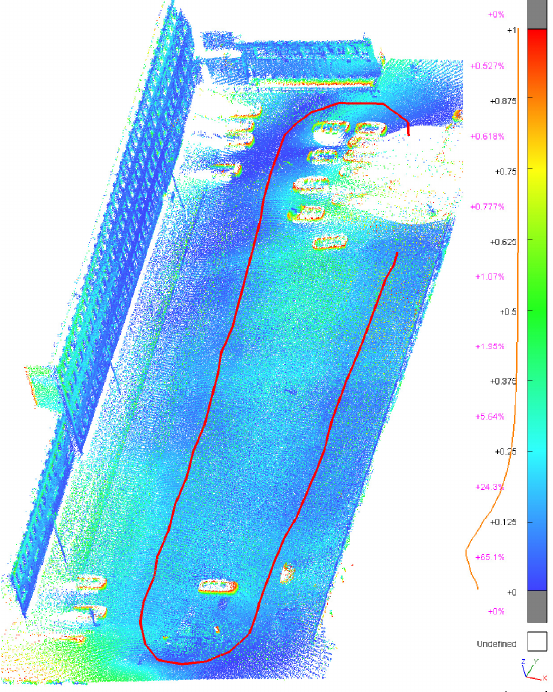
Figure 4. 3D discrepancies between TLS and MLS data (the absolute values of differences) in the test site. The red line denotes the clockwise trajectory of the vehicle. The empty data pockets are attributed to the cars in the parking lot. The horizontal scale denotes 5 metres.